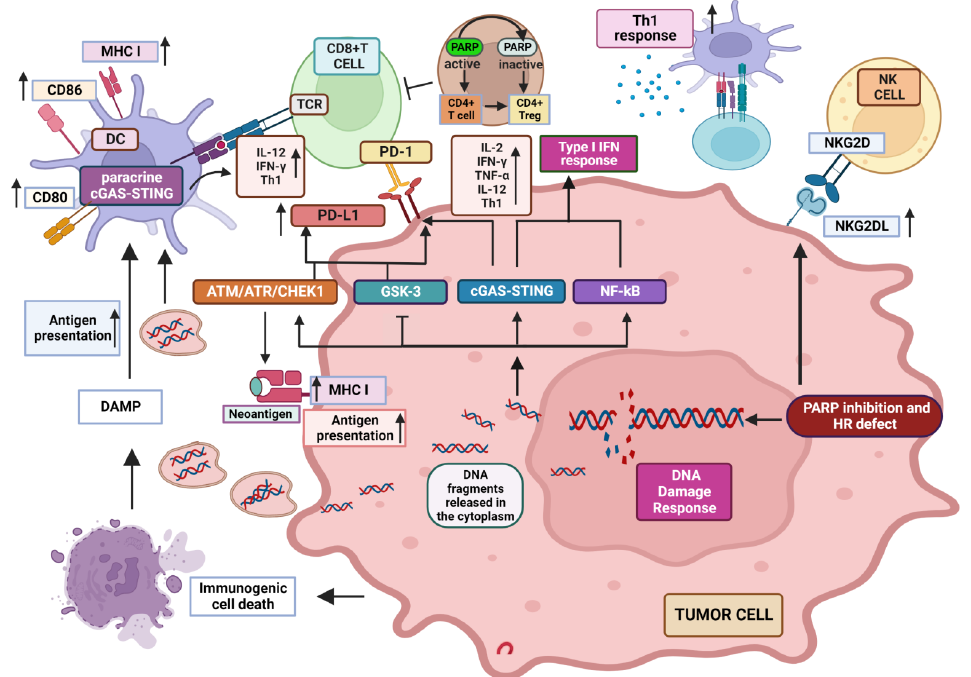
Figure 1. Recognized modifications induced by PARP inhibition in the TME. PARPi impair DNA repair which produces DNA fragments that are released in the cytoplasm, where they activate cGAS inducing STING pathway and the generation of a type I IFN inflammatory response. NF-kB is also activated, contributing to the production of inflammatory cytokines. DNA fragments can also be released extracellularly inducing paracrine GAS/STING response in DCs and increasing the expression of MHC molecules as well as antigen presentation. DDR response induces MHC expression in tumor cells, improving tumor-associated neo-antigen presentation induced by PARPi. PD-L1 expression is up-regulated via cGAS/STING, ATM/ATR pathway and GSK3 inactivation, potentially increasing the response to ICIs. PARPi induce NKG2D ligand expression, enhancing NK and CD8+ T cell anti- tumor cytotoxicity. See text for a more detailed explanation. “Created with BioRender.com.”